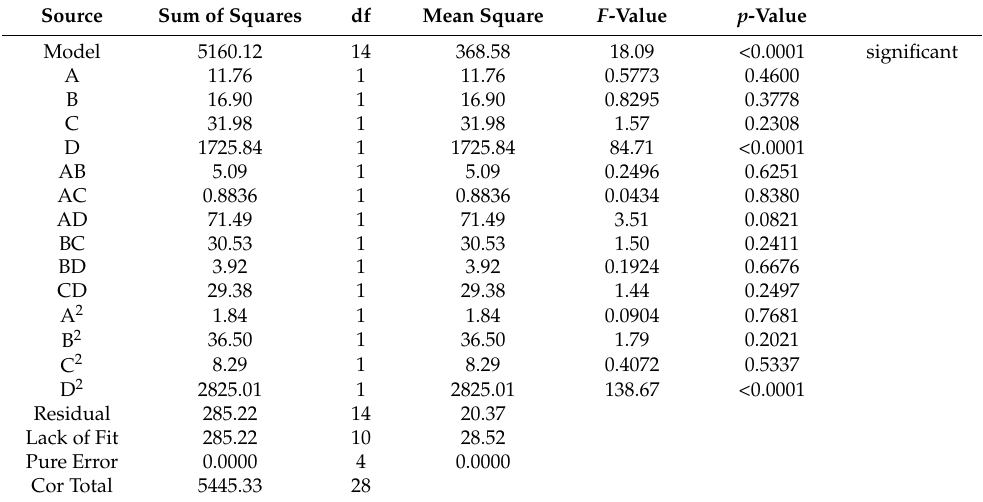
Table 5. Variance analysis of fan thrust.